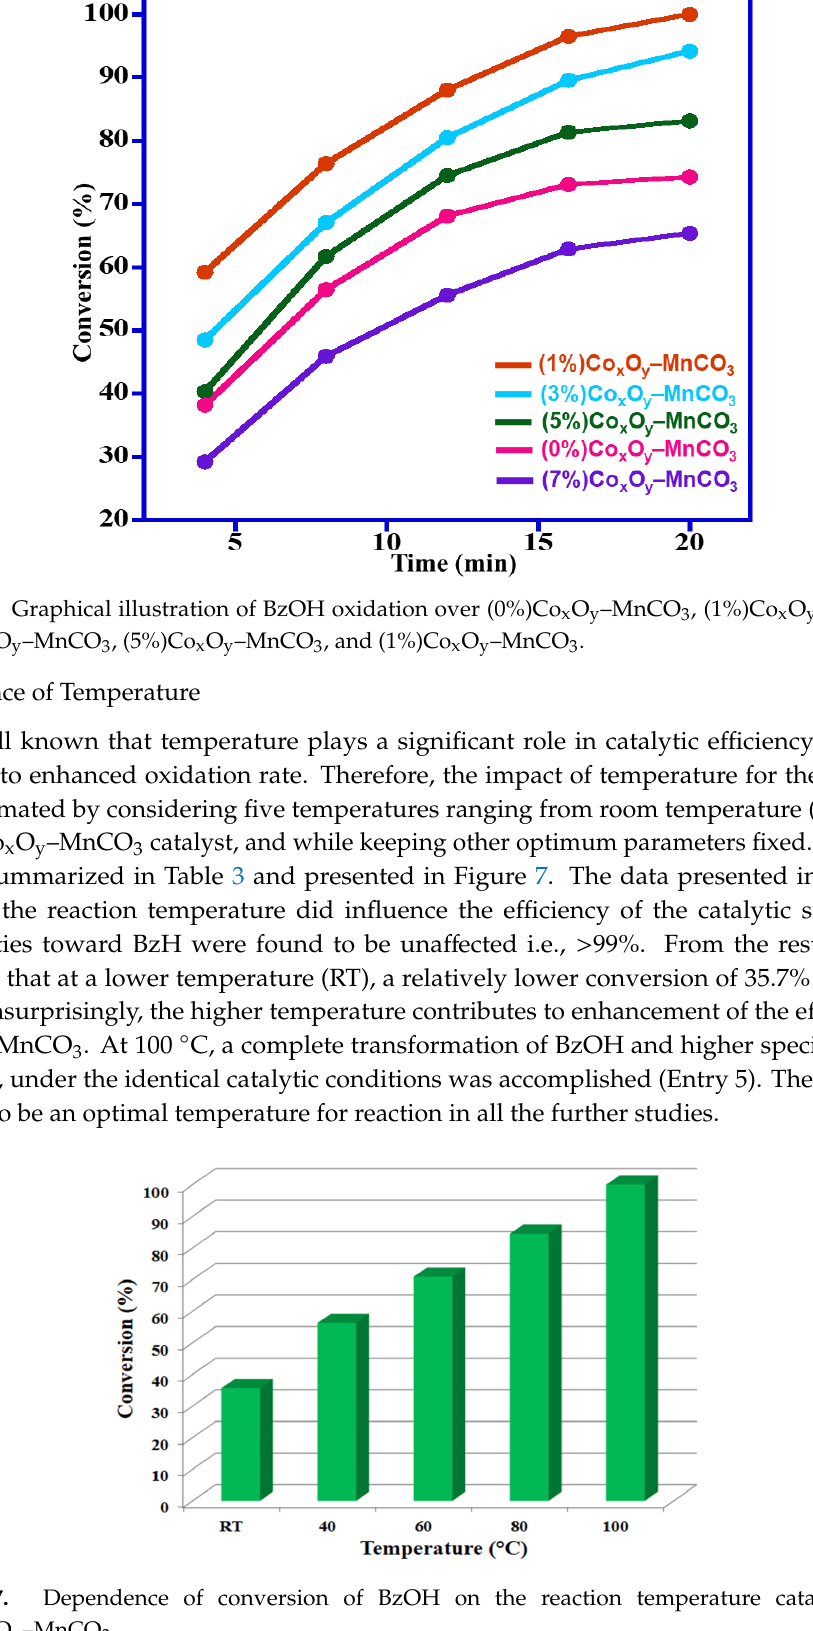
Figure 7. Dependence of conversion of BzOH on the reaction temperature catalyzed by (1%)Co x O y –MnCO 3 .